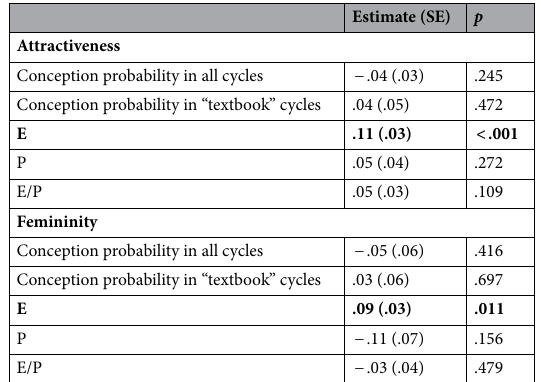
Table 2. Associations between level of fertility cue and ratings of attractiveness and femininity for each of the separate models (statistically significant differences in bold).